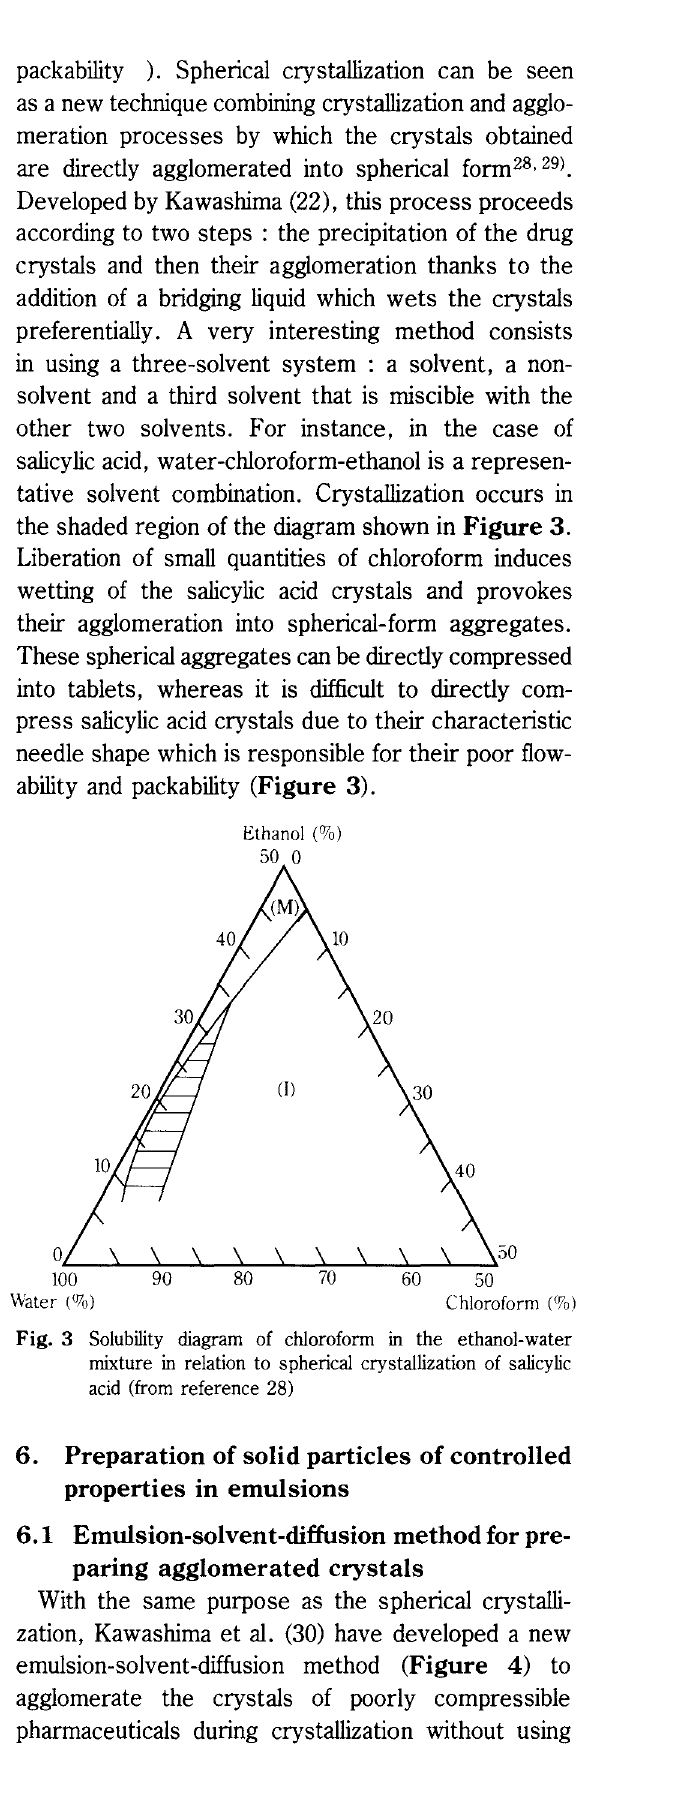
Fig. 3 Solubility diagram of chloroform in the ethanol-water mixture in relation to spherical crystallization of salicylic acid (from reference